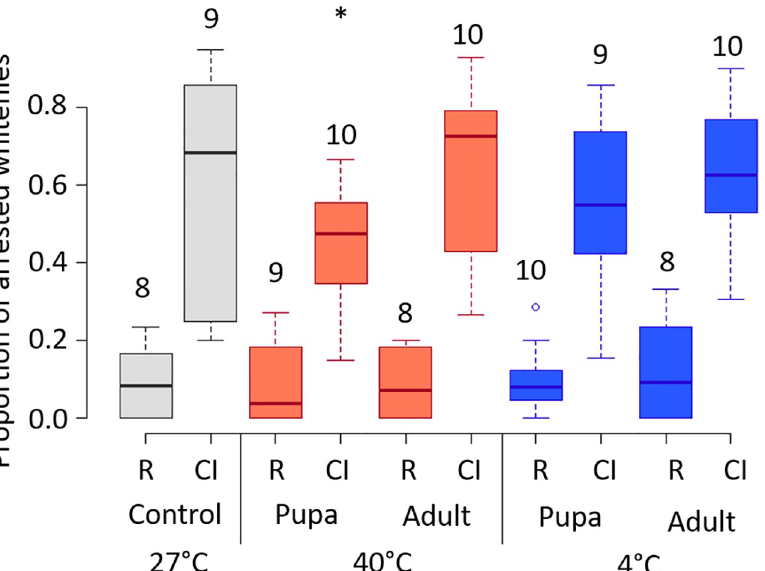
Fig 7. Proportion of arrested whiteflies (proxy for CI-mortality) generated from crosses involving male wasps exposed to different temperature shocks. Color of bars denotes temperature treatment (grey = 27˚C, red = heat shock at 40˚C, blue = cold shock at 4˚C). Treatments are also separated by the stage at stage temperature exposure began. R = rescue cross, C(+) female x C(+) male. CI = CI cross, C(-) female x C(+) male. Asterisks denote significant differences compared to respective crosses at 27˚C. Numbers represent replicates for each cross. N = 8–10, with the mean offspring per male = 15.3.